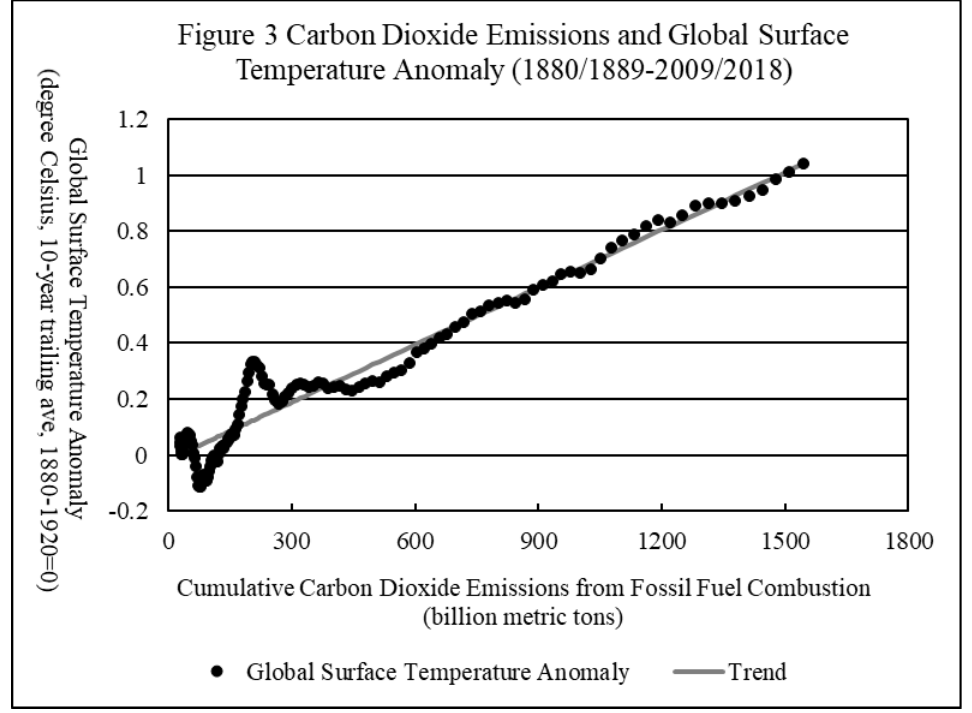
Sources: World carbon dioxide emissions from fossil fuels combustion from 1750 to 1964 is from Boden, Marland, and Andres (2017). World carbon dioxide emissions from fossil fuels combustion from 1965 to 2018 is from BP (2019). Global average temperature anomaly from 1880 to 2018 is from NASA